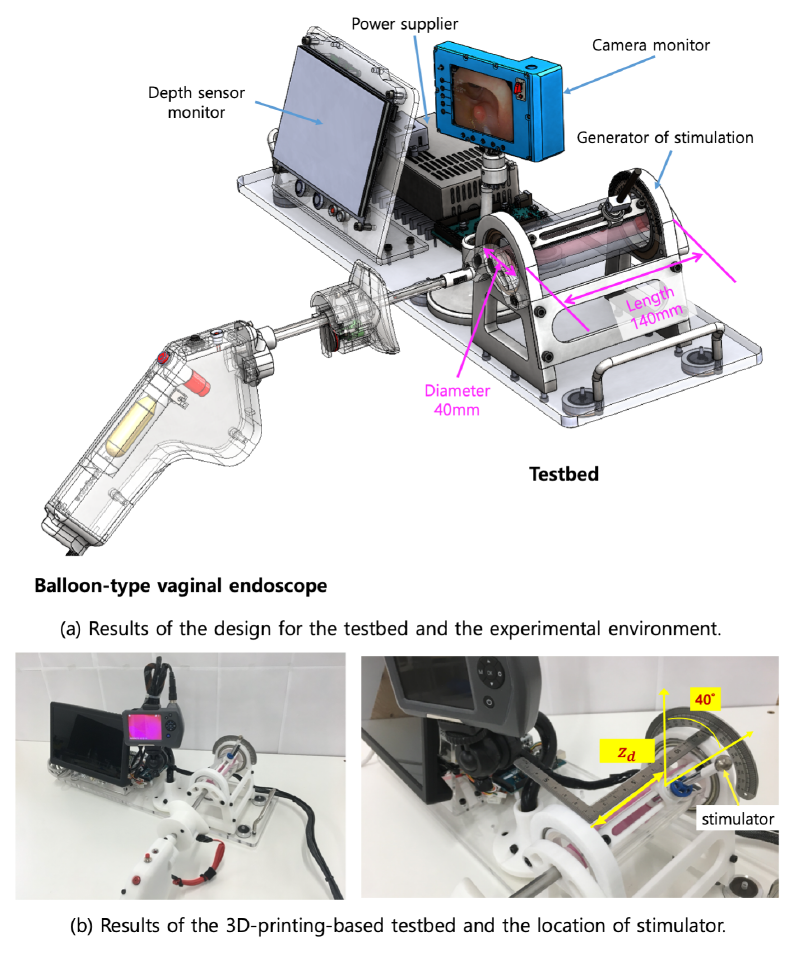
Figure 7. Design for the testbed based on 3D printing technology to confirm two main points: ( a ) safe insertion and ( b ) exact